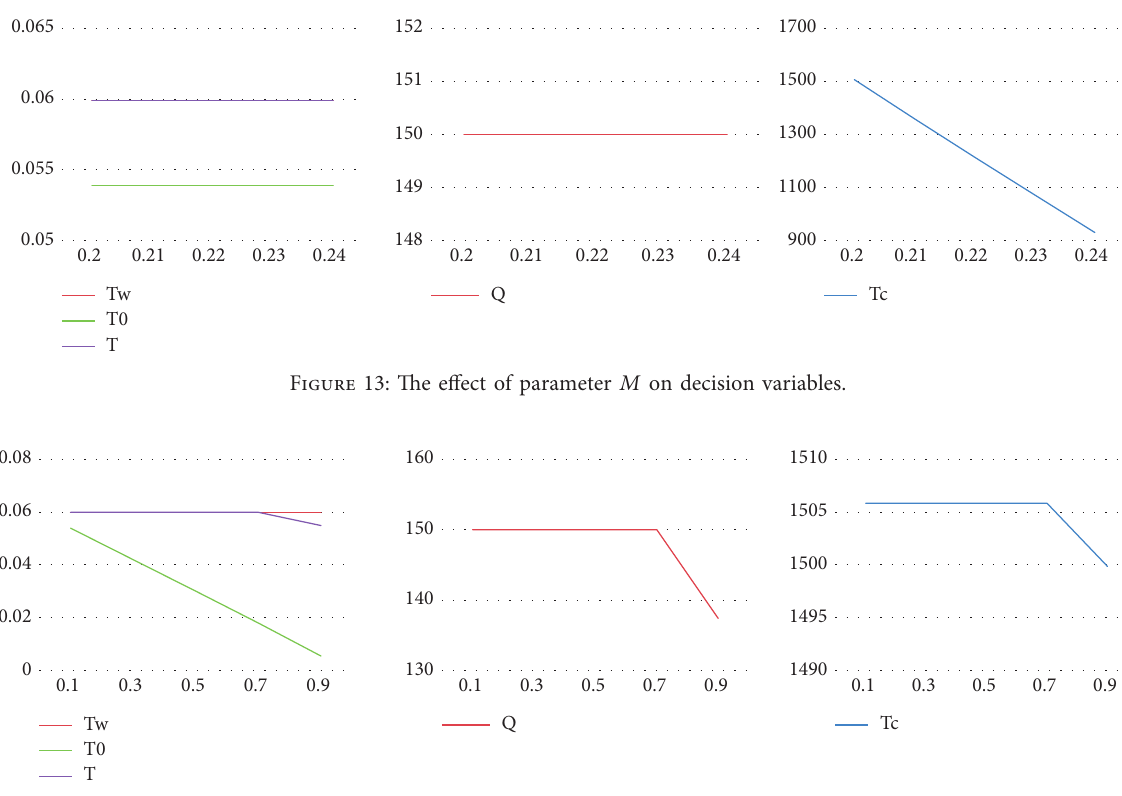
Figure 14: The effect of parameter α on decision variables.